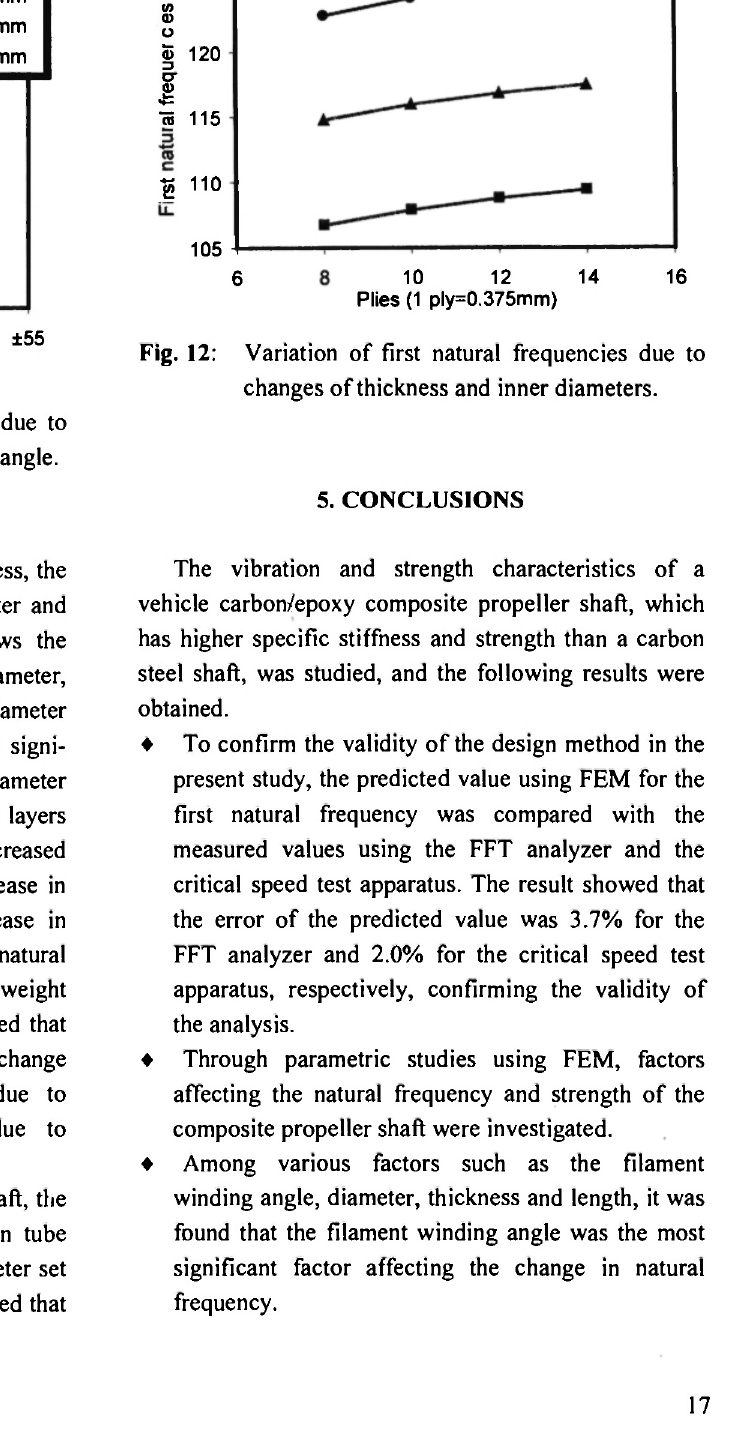
Fig. 12: Variation of first natural frequencies due to changes of thickness and inner diameters.